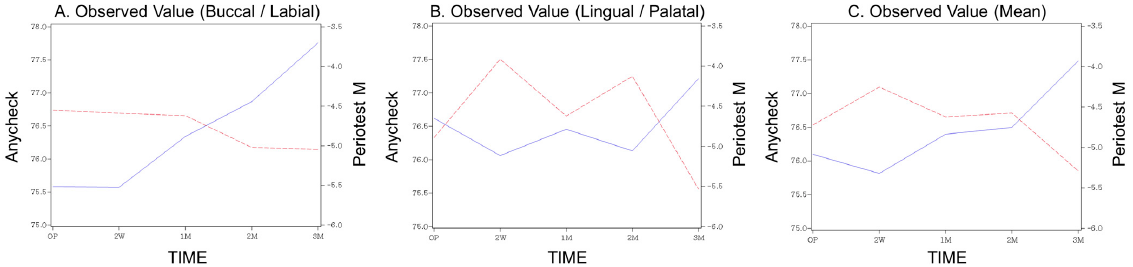
Figure 3. The observed values over time. ( A ) Buccal, ( B ) lingual, ( C ) mean. Table 3. The implant stability measured by damping capacity analysis devices after implant placement.